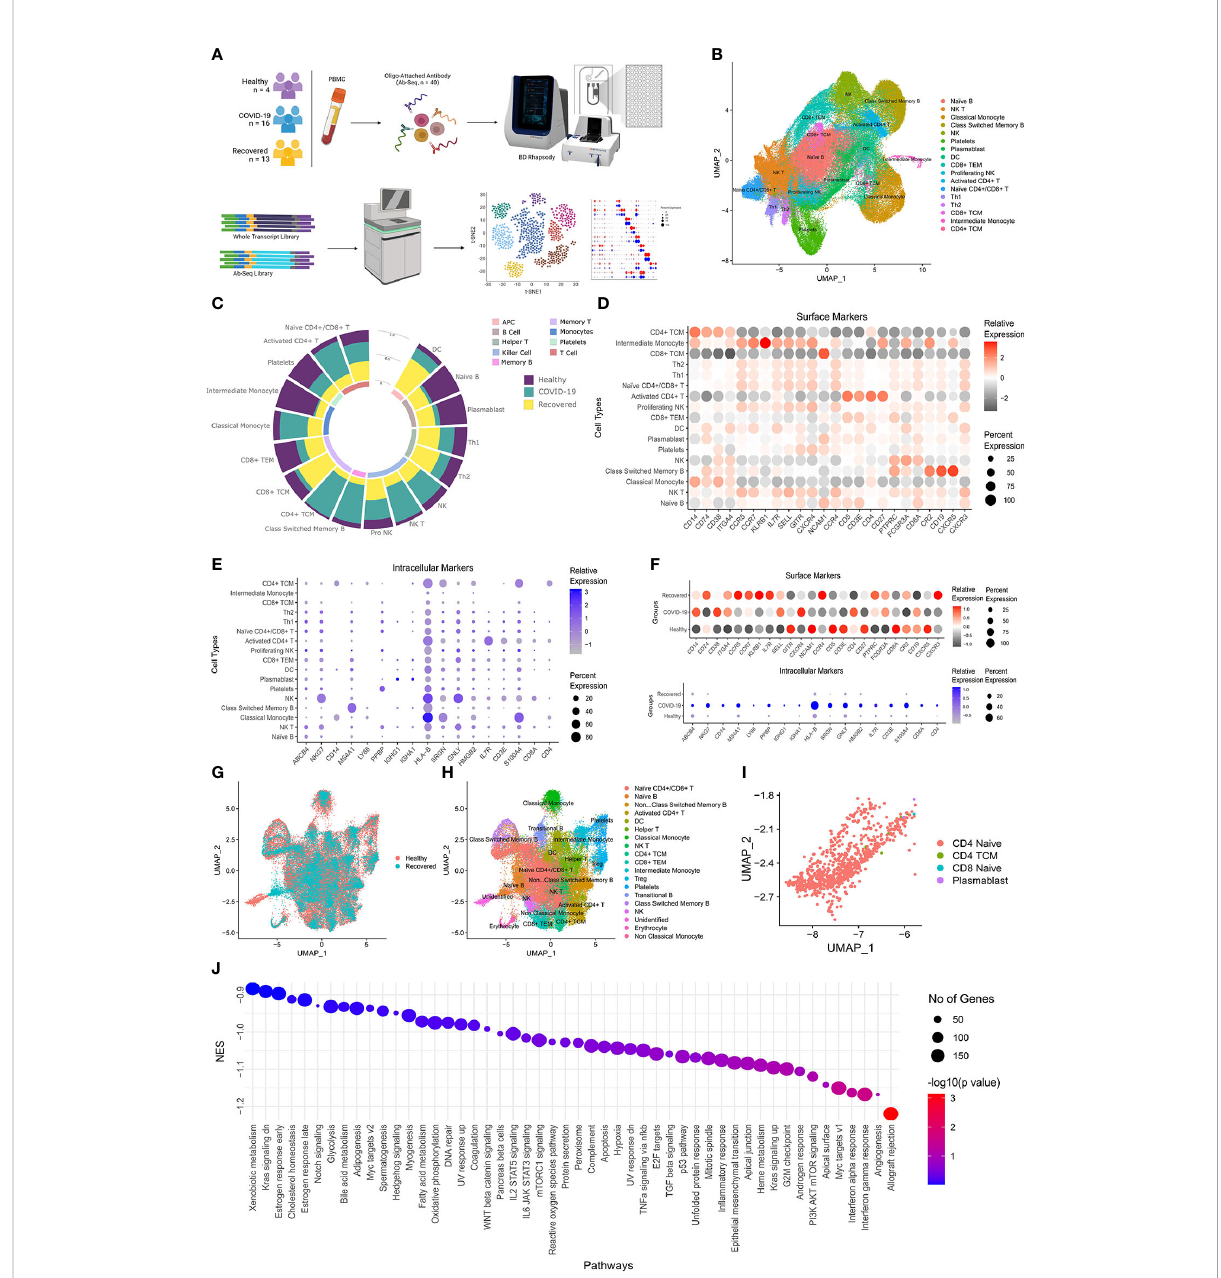
FIGURE 1 Cellular Heterogeneity across Healthy, Infected and Recovered COVID-19 Individuals. (A) Sample distribution and schematic work fl ow for the scRNA-seq, followed by analysis for the cellular heterogeneity and differential expression. (B) UMAP visualization of the 124726 cells across the healthy, active COVID-19 and the recovered individuals. (C) Frequency of cell types across the three groups, normalized to the total number of cells. (D, E) Cell type speci fi c expression of (D) Surface markers, and (E) RNA level. Color scale denotes the relative expression whereas circle size denotes the percent of cells expressing the marker. (F) Expression of cell type speci fi c markers across the three groups. (G) UMAP visualization of healthy vs recovered comparison group showing no batch effect between the two groups, the box highlights the cluster absent in the recovered individuals. (H) UMAP visualization of healthy vs recovered comparison group with cell type annotation, the box highlights the unidenti fi ed cluster. (I) UMAP visualization of the unidenti fi ed cluster after machine learning-based cell type annotation. (J) GSEA of differentially expressed genes between novel subset of the Naive CD4+ T cell and existing Naive CD4+/CD8+ T